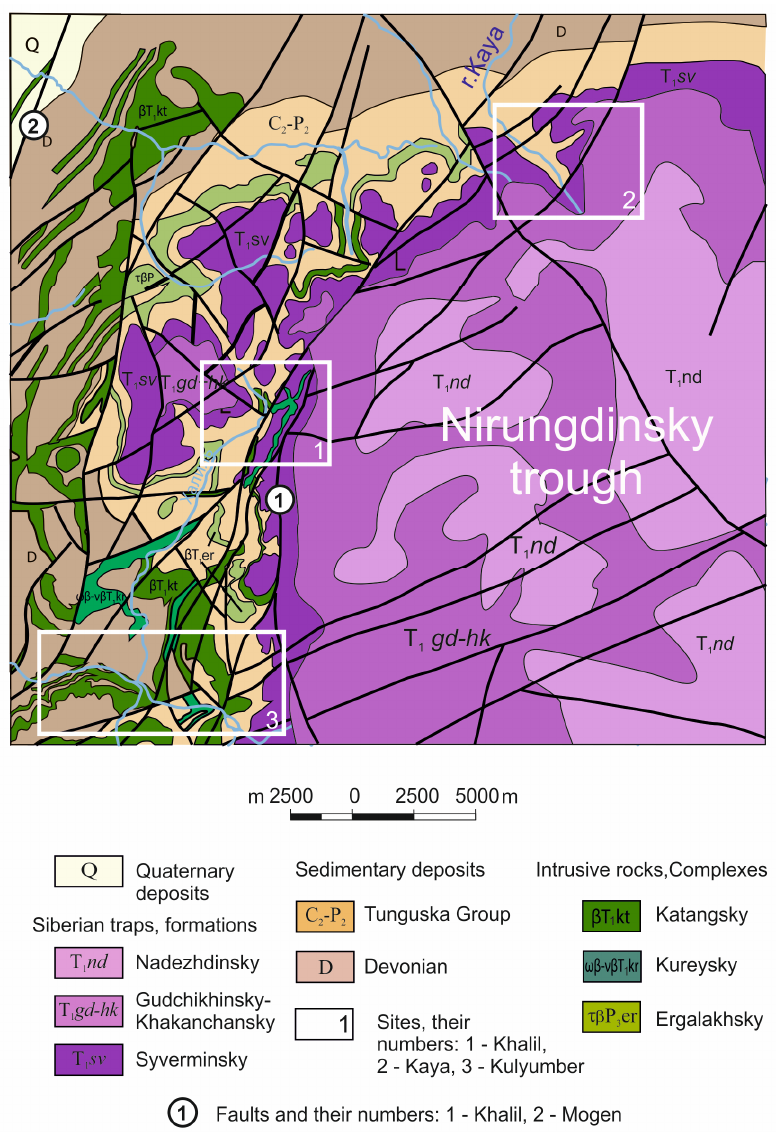
Figure 3. Geological map of the Kulyumber river valley (after Ltd. Norilskgeology data with the authors’ corrections). Position of the studied area is shown in Figure 1.